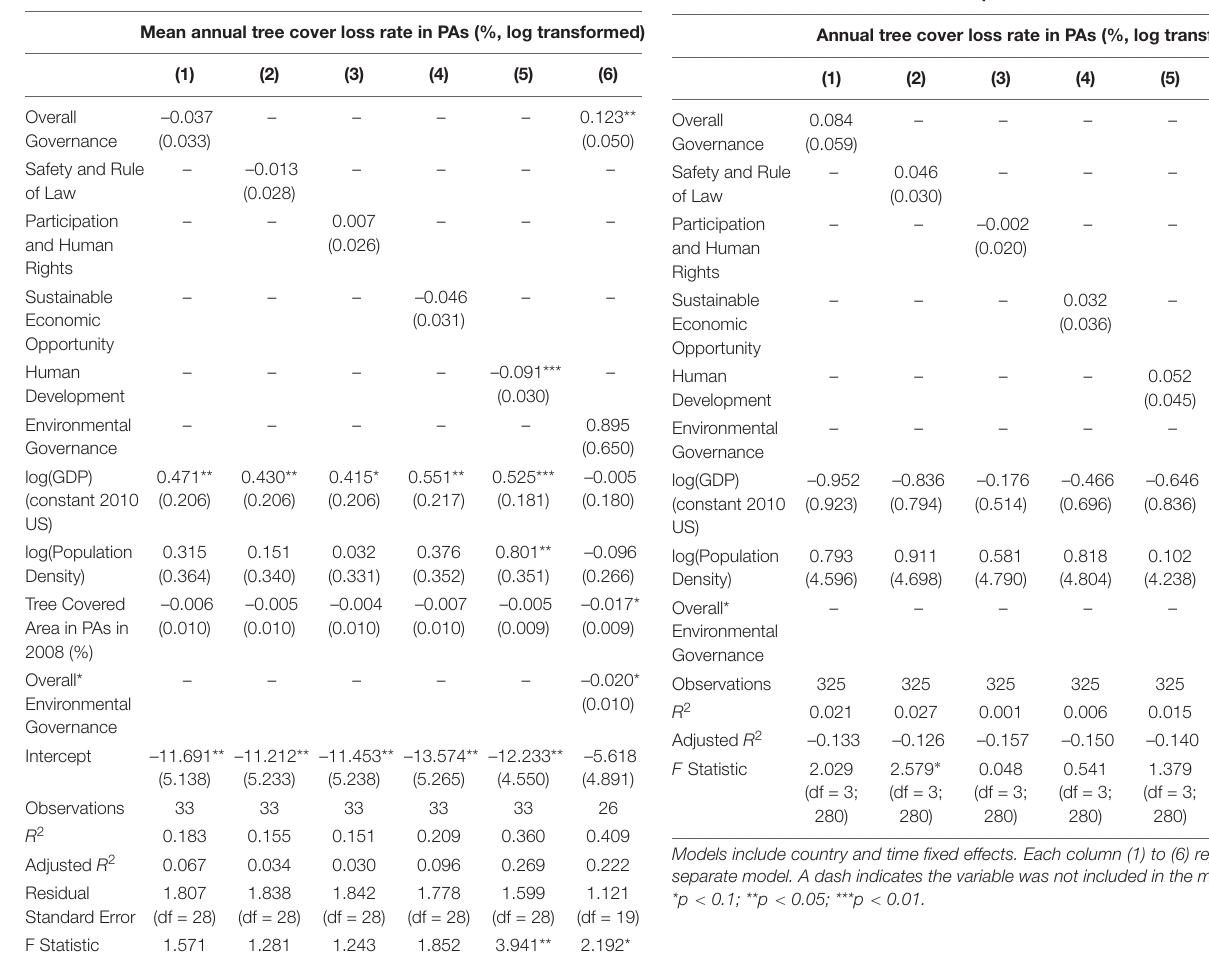
TABLE 1 | Summary of parameter estimates (SE) from linear regression of tree cover loss against governance and additional covariates, comparing mean values across countries.